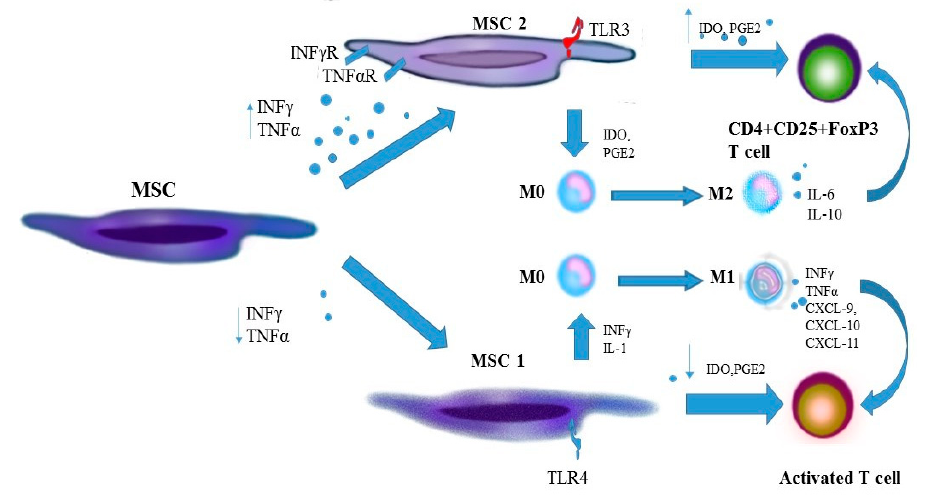
Figure 2. Polarization of MSC into an anti-inflammatory and pro-inflammatory phenotype and impact of anti-inflammatory and pro-inflammatory MSC on T cells activity. IFN- γ , interferon γ ; TNF- α , tumor necrosis factor α ; TLR, Toll-like receptor; MSC, mesenchymal stem cell; IL, interleukin; PGE2, prostaglandin E2; IDO, indolamine M, monocyte; CXCL, chemokine.